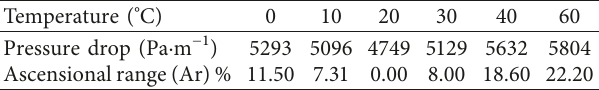
Table 4: Pressure drop of the pipeline transport at different temperatures.